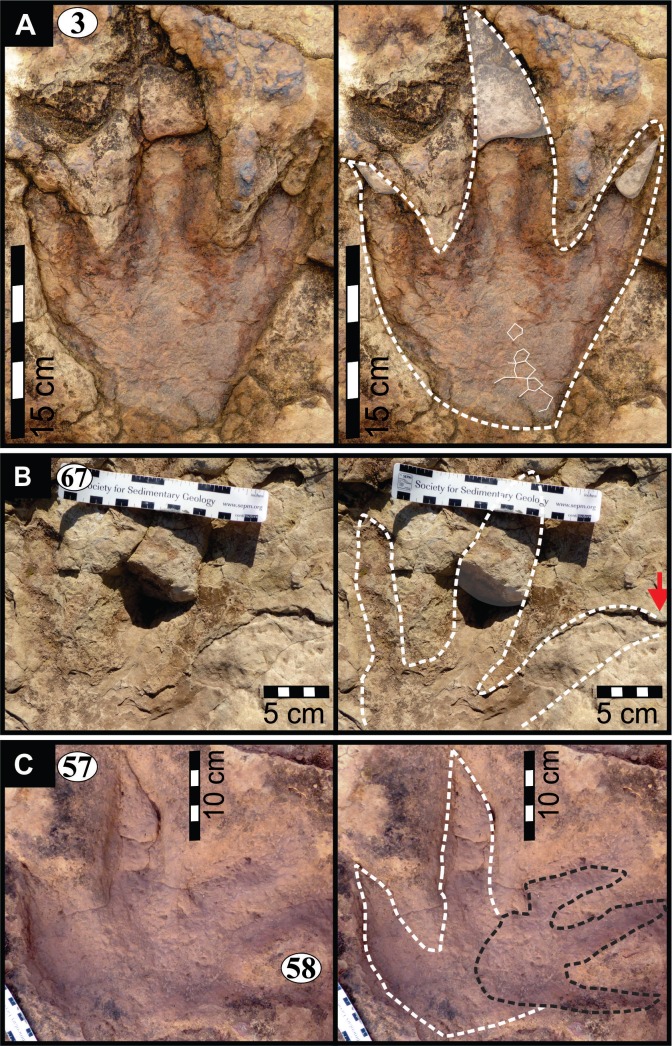
Photographs and interpretative outline tracings of individual tracks (morphotype A) at the Mafube dinosaur track site.(A) Track#3 is one of the best preserved tracks with steep track walls and a clearly defined heel. The desiccation cracks within the foot impression indicate that it is a true track. Note the natural cast at the tips of digits II and IV, the claw mark on digit II and slightly curved, V-shaped digits. (B) Track #67 shows sandstone natural casts filling digit III and a claw mark on the rightly-curved digit IV (red arrow). (C) Overlapping tracks #58 and 57 point in different directions with angle of difference between digits III being 78°. Note the pitted textures (4 mm in diameter) in track #57 and three rounded, straight digits associated with track #58.